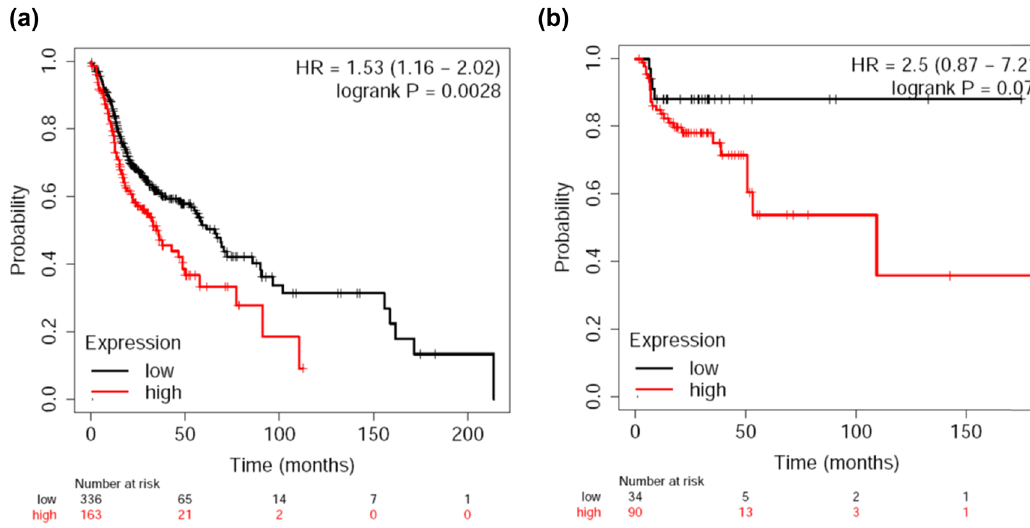
Figure 6: Survival curve of between MTHFD2 low and high expression groups ( a ) overall survival; ( b ) progression free survival.